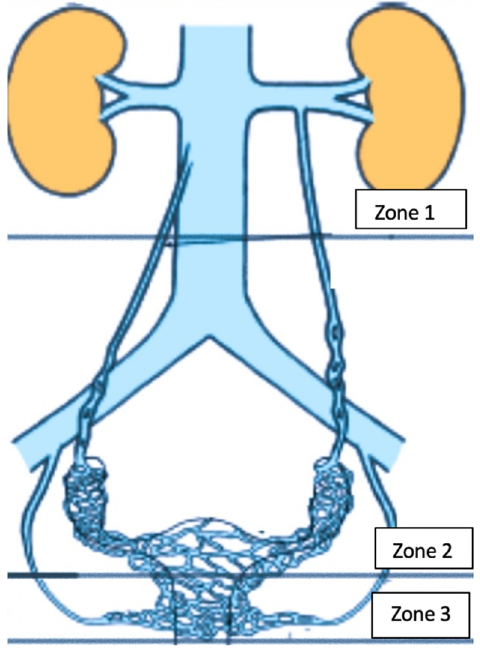
Figure 1. Clinical manifestations of pelvic venous disorders with involvement of three anatomical areas: Zone 1: left renal vein; Zone 2: ovarian and iliac veins plus the pelvic venous plexus; Zone 3: vulvar and perineal varices of pelvic origin.